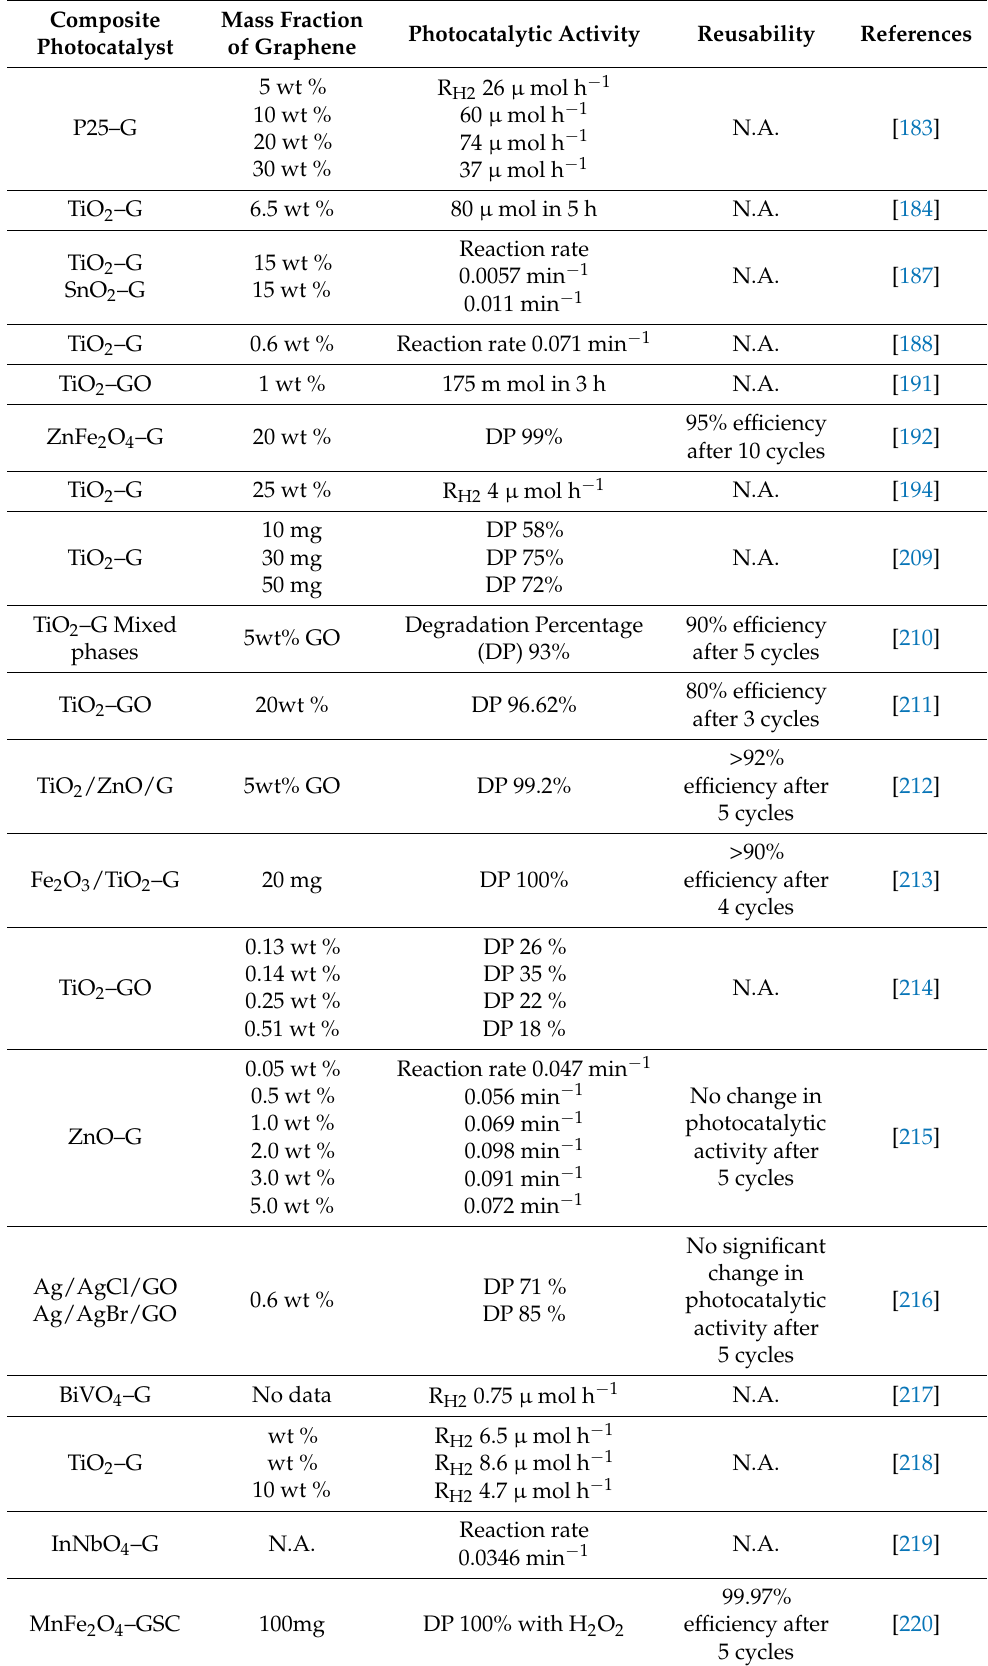
Table 2. Photocatalytic properties of graphene-based composites